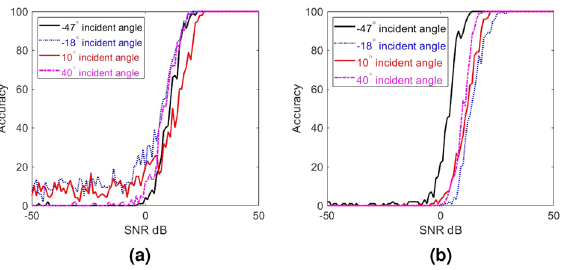
Figure 7. AoA estimation accuracy (in percentage) with incident signal sampled from a) all 24 waveguides with a uniform mask ( a replica of the estimation accuracy presented on Fig. 3) and b ) 6 waveguides with five random masks. The same set of AoAs is used in both cases.